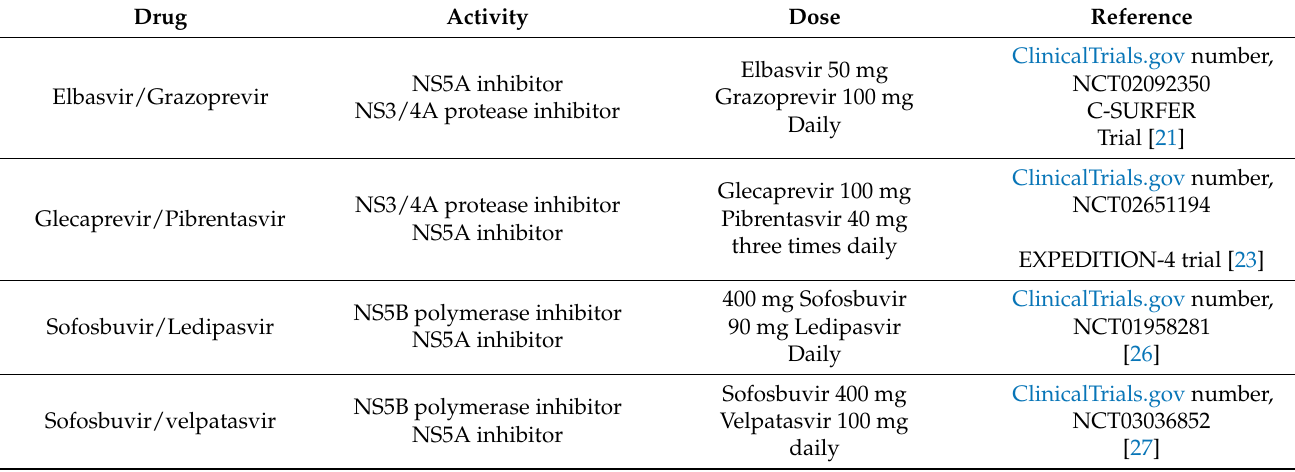
Table 2. DAAs for treatment of HCV-associated liver disease in CKD (according to AASLD/IDSA guidelines). Drug Activity